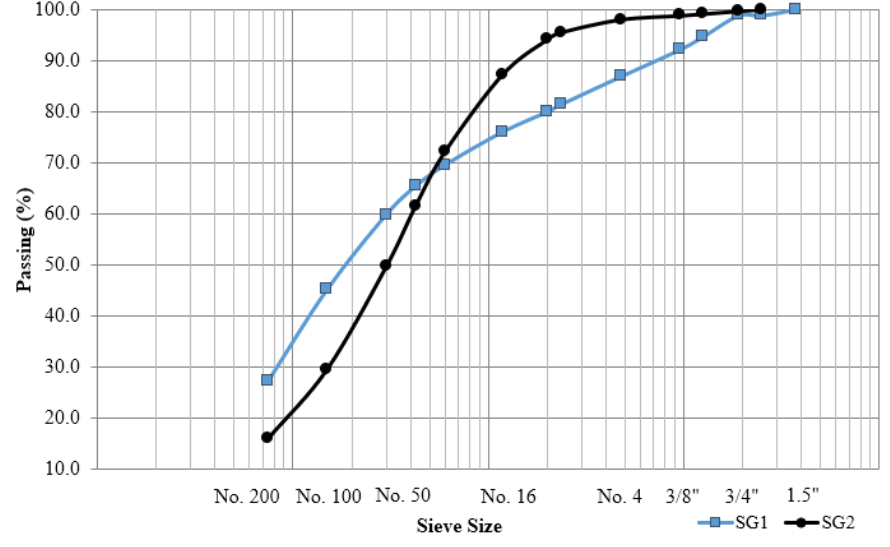
Figure 4. Subgrade soil gradations.